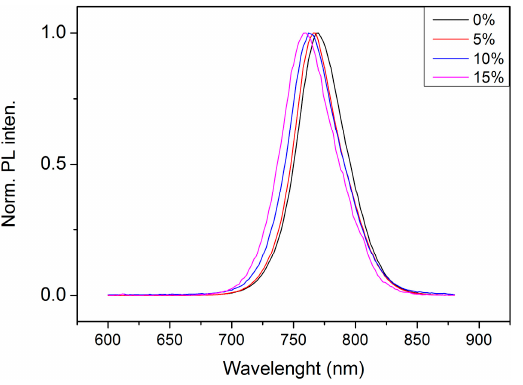
Figure 7. Photoluminescence spectra of the perovskite layers with different cesium concentration. Table 3. Results of PL analysis: λ i is peak center and w i is full width at half maximum of the Gaussian peaks, λ max is the peak maximum, τ i and A i are the decay time and the amplitude of the three-exponential function, and τ av is the amplitude weighted average decay time.